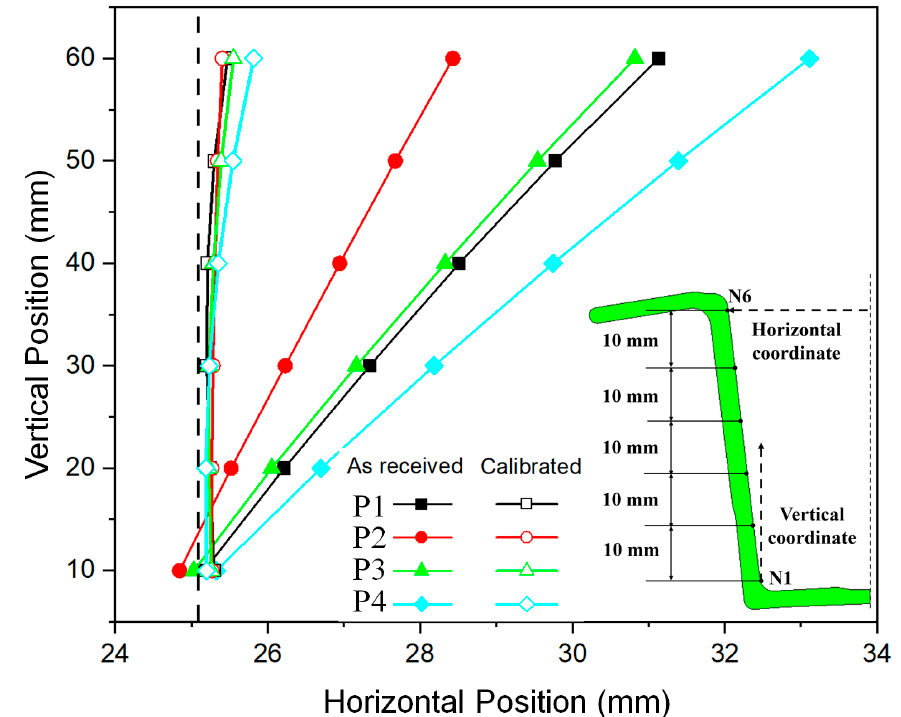
Figure 5. Comparison of profile sidewall dimensions before and after calibration processes in four samples, P1–P4.